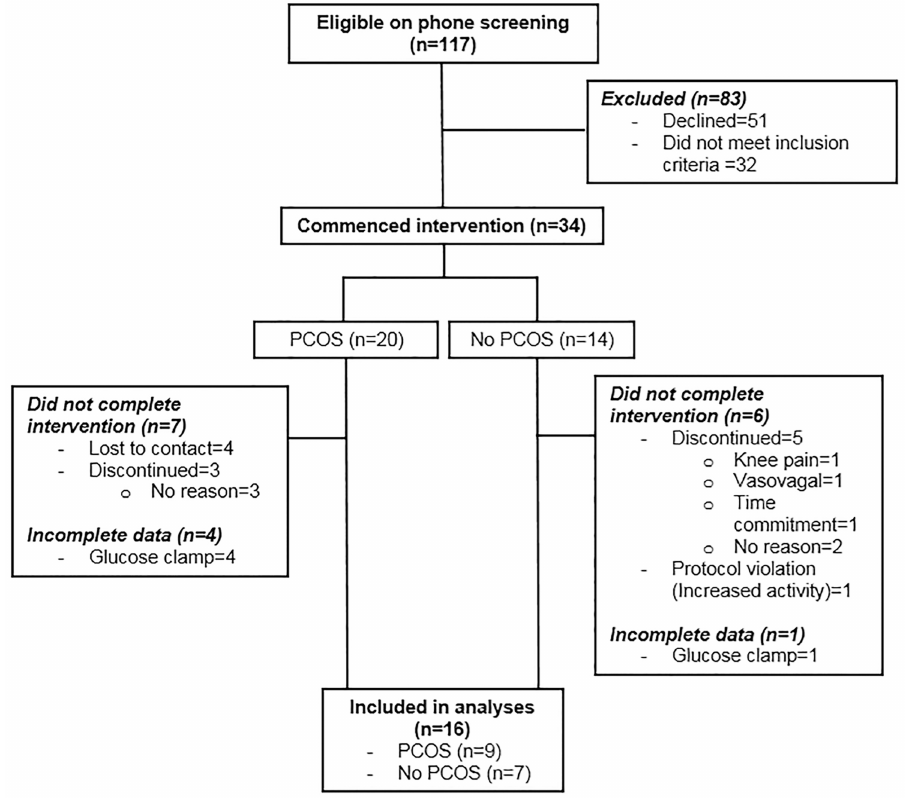
Fig 1. Consolidated Standards of Reporting Trials (CONSORT) flowchart describing progress through the